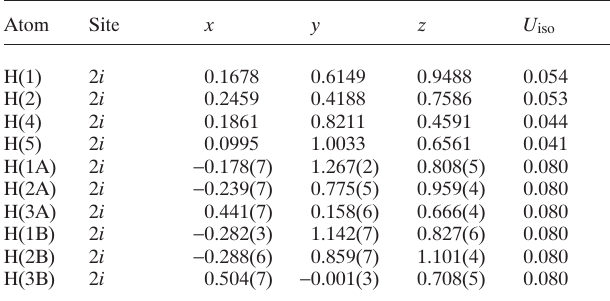
Table 1. Data collection and